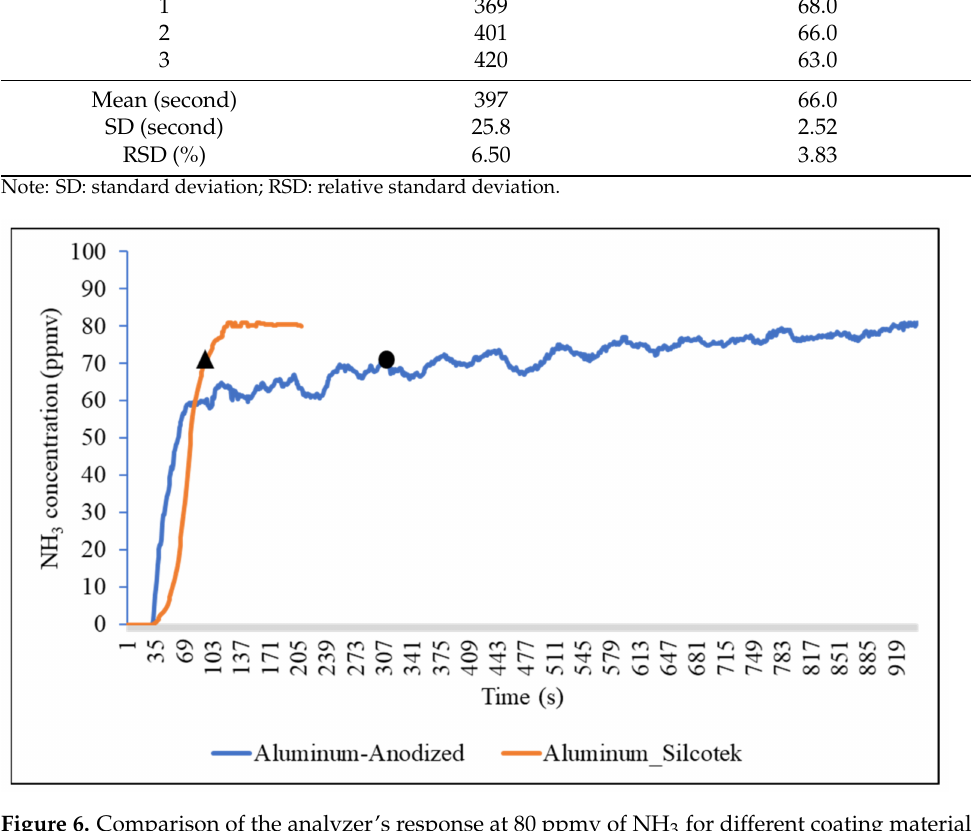
Figure 6. Comparison of the analyzer’s response at 80 ppmv of NH 3 for different coating materials of the gas